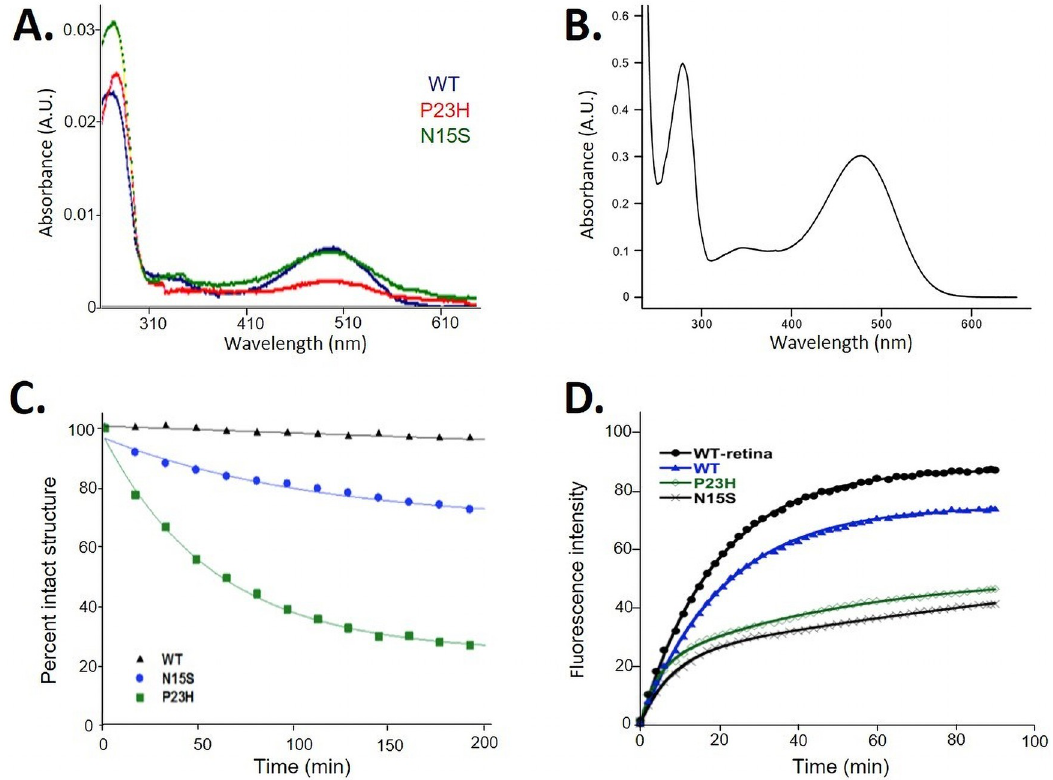
Fig 2. A . Overlay of absorbance spectra of rhodopsin proteins expressed in COS-1 cells and purified using 1D4-affinity chromatography. Proteins were eluted in phosphate buffered saline in order to elute both folded and misfolded portions. B. P23H rhodopsin obtained from stable cell line P23H and eluted in 2 mM sodium phosphate pH 6, which only elutes the folded fraction. C . Rhodopsin stability measured by loss of 500 nm chromophore over time at 37˚C. Absorbance spectra of WT, N15S and P23H rhodopsin expressed in the presence of 9-cis retinal at 37˚C were measured over time, and the decrease in absorbance at 500 nm was expressed at percent of intact structure. D. Rhodopsin Meta-II decay monitored by the use of fluorescence spectroscopy. Fluorescence spectra of rhodopsin Meta-II decay of WT, N15S and P23H rhodopsin expressed in the presence of 9- cis